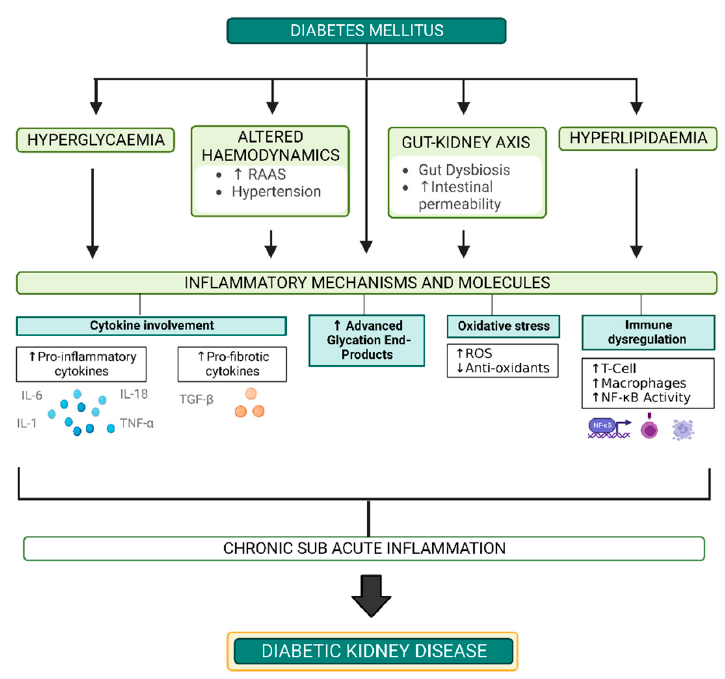
Figure 2. Overview of the mechanisms implicated in DKD pathogenesis. RAAS: Renin Angiotensin Aldosterone System, ROS: Reactive Oxygen Species, NF- κ B: Nuclear Factor Kappa B, IL-6: Interleu- kin 6, IL-1: Interleukin 1, IL-18: Interleukin 18, TNF- α : Tumour Necrosis Factor Alpha, TGF- β : Trans- forming Growth Factor Beta, ↑ : Increased, ↓ : Decreased. Created with Biorender.com.